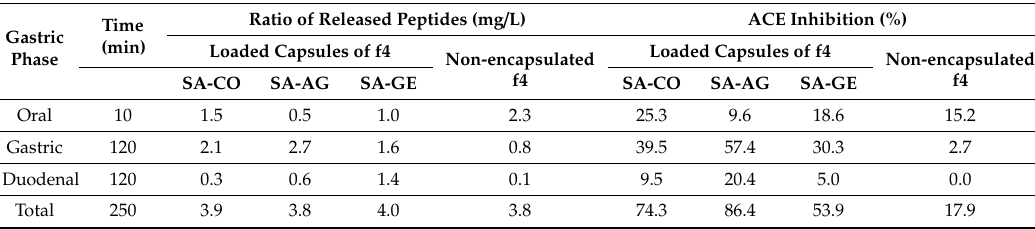
Table 2. Release kinetics of gastric phases of f4 peptide fraction from capsules SA-CO, SA-AG, SA-GEm and non-encapsulated